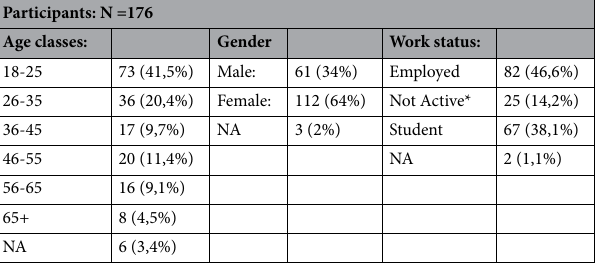
Reggio Emilia (in the main town of the province) between November 2015 and May 2016. In Vignola and Mirandola the experimental sessions were organized in the municipalities’ council chambers while in Reggio